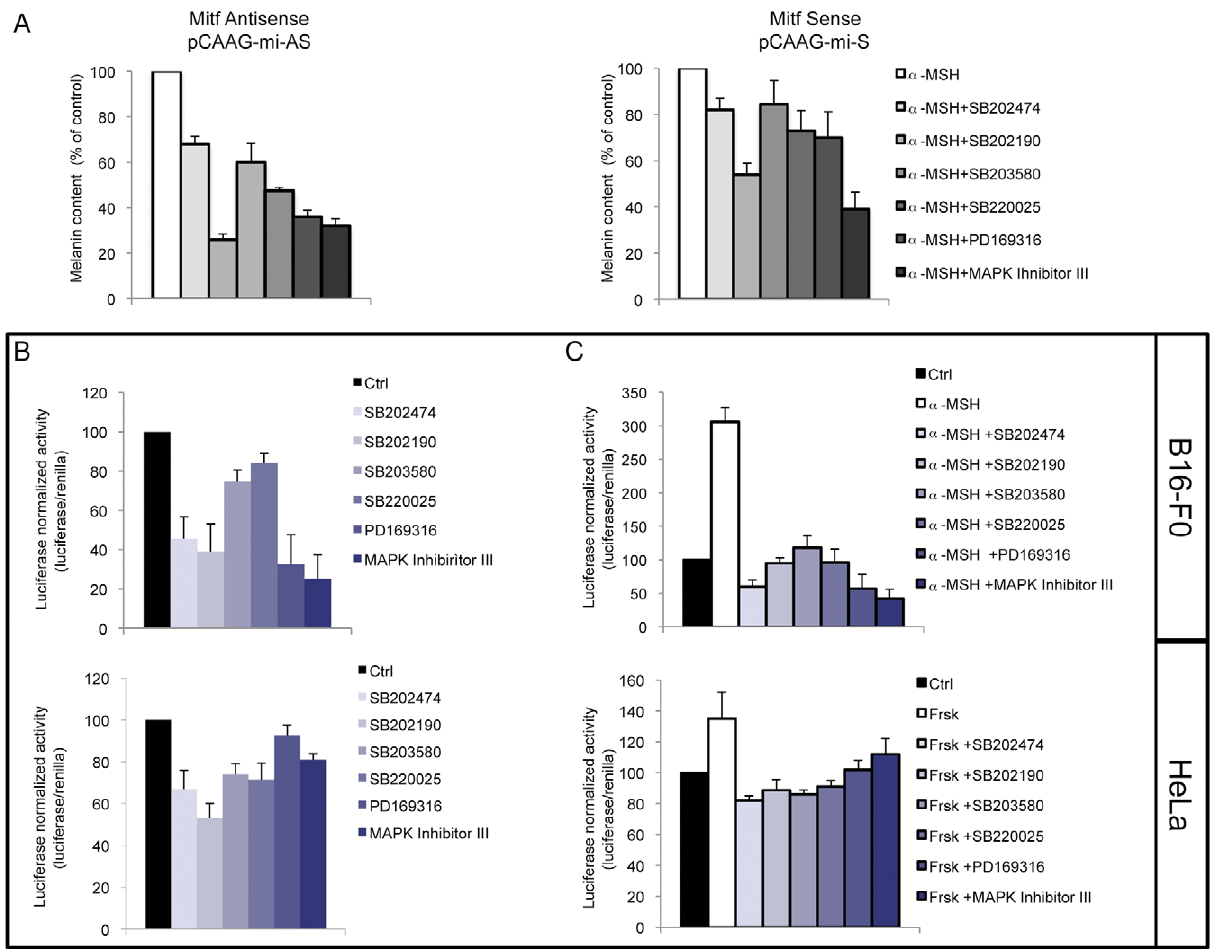
Figure 5. Analysis of the role of Mitf expression in pyridinyl imidazoles-dependent melanogenesis inhibition. (A) To B16-F0 melanoma cells were transiently transfected with a plasmid encoding for Mitf cDNA (pCAAG-mi-S) or a control construct carrying Mitf cDNA in antisense orientation (pCAAG-mi-AS). Following incubation with a -MSH (0.1 m M) in presence of pyridinyl imidazoles (SB202474, SB202190, SB203580, SB220025, PD169316 20 m M: MAPK Inh III 10 m M) for 72 h, or not, the extracellular and intracellular levels of melanin were determined as described above. The data show the mean 6 SD of three experiments performed in duplicate. (B–C) Analysis of luciferase activity of the Mitf melanocyte-specific promoter (M promoter) in the presence of pyridinyl imidazoles in B16-F0 and HeLa cells. Twenty-four hours after transient transfection cells were treated with PI compounds in presence (C) or not (B) of a -MSH (0.1 m M) (B16-F0) or forskolin (1 m M) (HeLa). Luciferase activity was assayed after 6 h of treatment. Firefly luciferase activity, normalized to the corrisponding renilla luciferase activity was expressed as fold change compared with control cells. Values represent mean 6 SD of three representative experiments performed in duplicate.